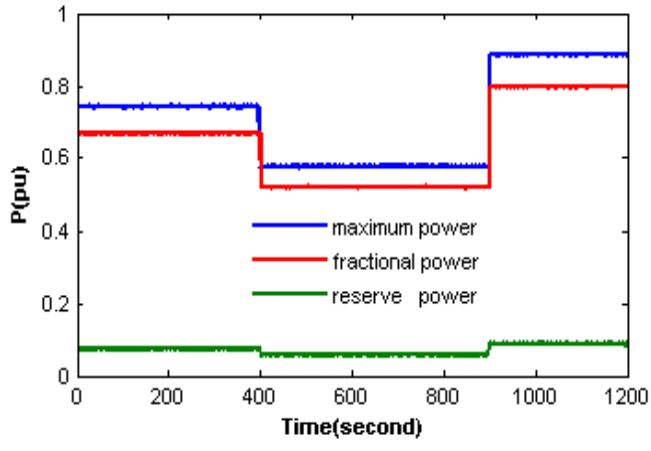
Figure 6. Module power. Figure 6. Module Table 1. Weighting factor corresponding to different irradiations.